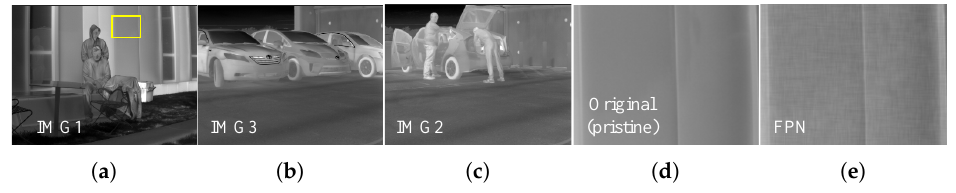
Figure 8. Images used for simulations (refer Tables 4 and 5), and visualized noise. ( a – c ) original pristine images; ( d ) magnified region of image 1 (pristine image); ( e ) RNU of ( B u , B v , σ u , σ v ) = (20, 20, 25,